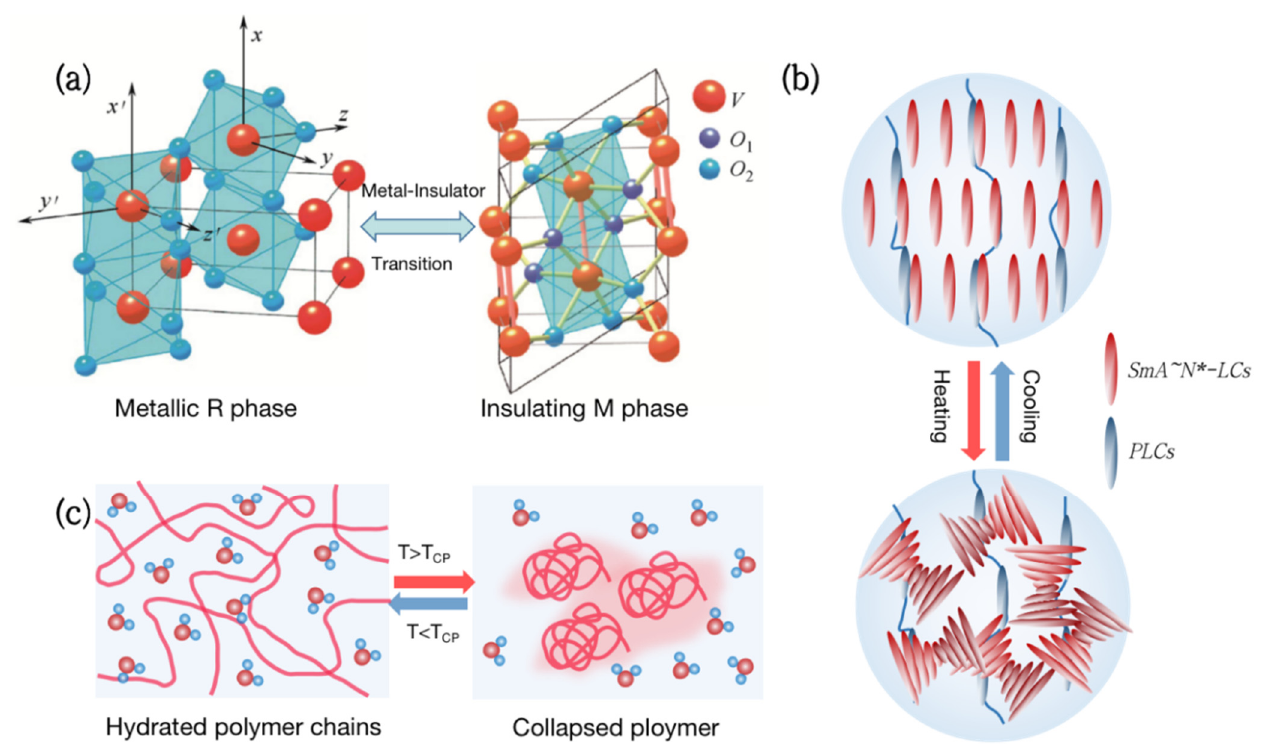
Figure 1. Types of thermochromic smart windows. ( a ) Metal-insulator phase transition (MIT) of vanadium dioxide (VO 2 ). ( b ) Liquid crystal changes transmittance by adjusting molecular orien- tation in response to temperature. ( c ) Thermochromic hydrogels change transparency reversibly with